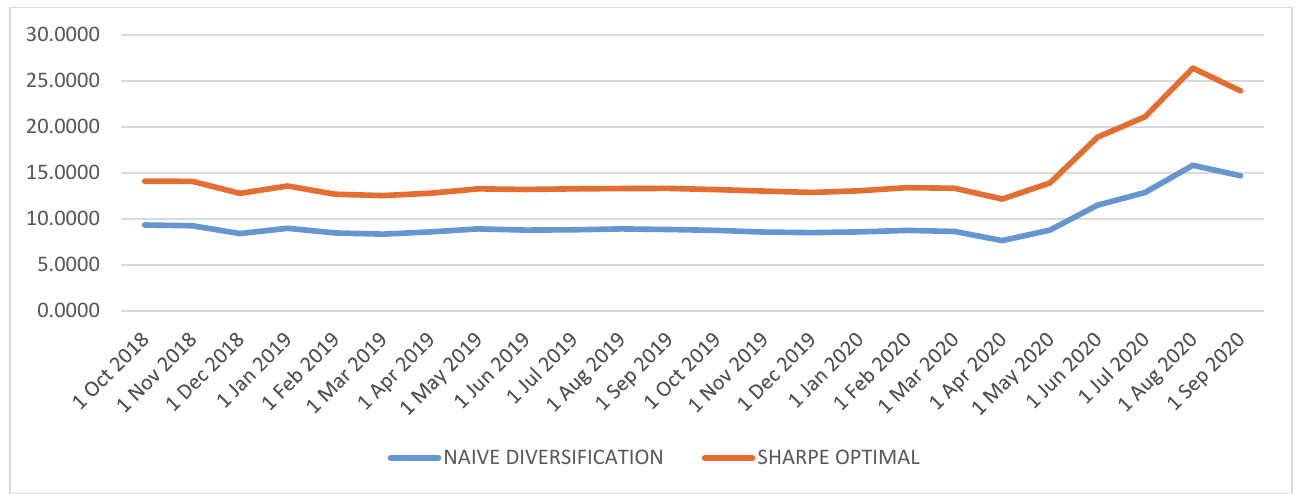
Fig. 5. Bottom rating portfolio constituents (Market Cap)